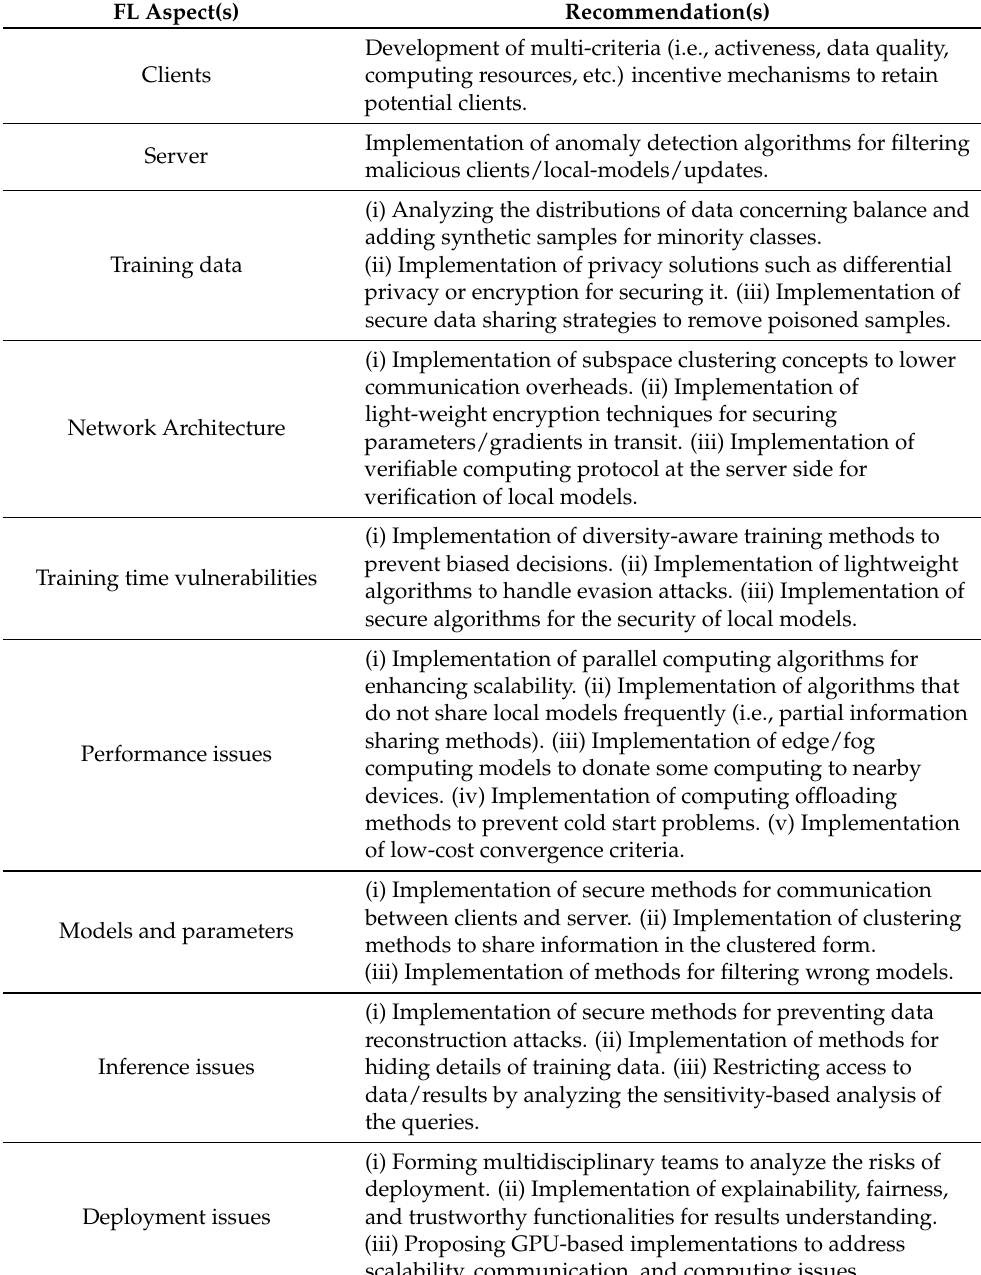
Table 5. Valuable recommendations to address technical challenges in the FL